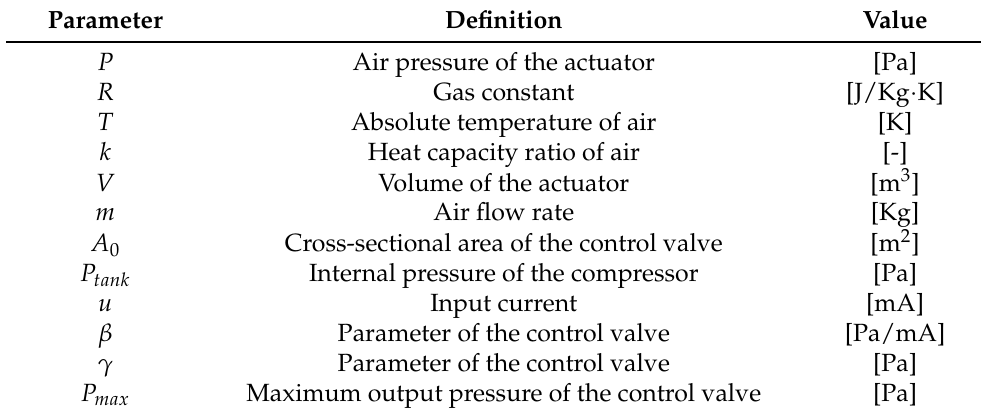
Table 2. Parameters of the pneumatic